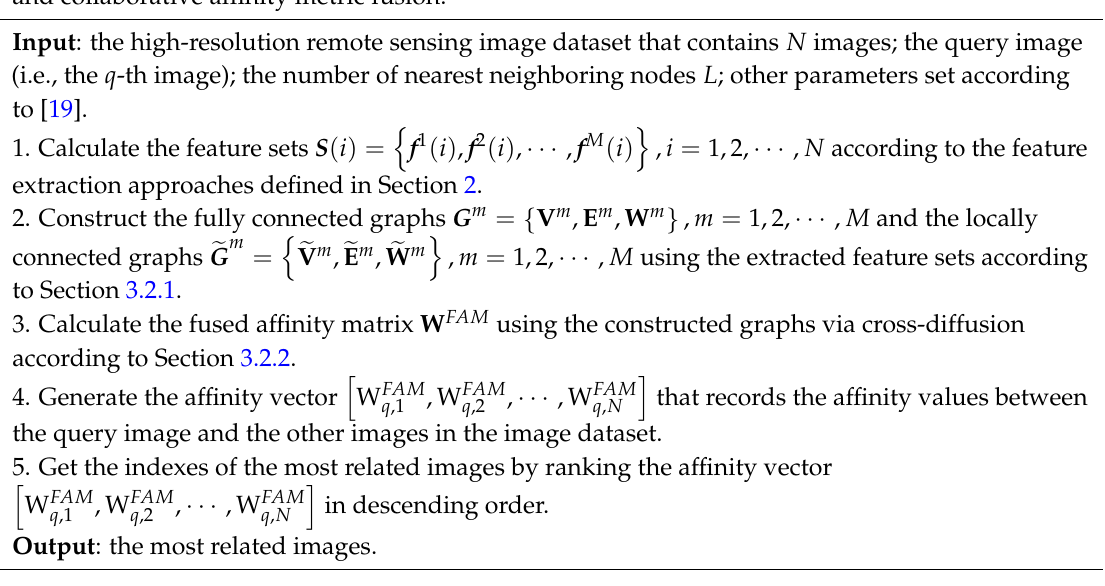
Algorithm 1. High-resolution remote sensing image retrieval via multiple feature representation and collaborative affinity metric